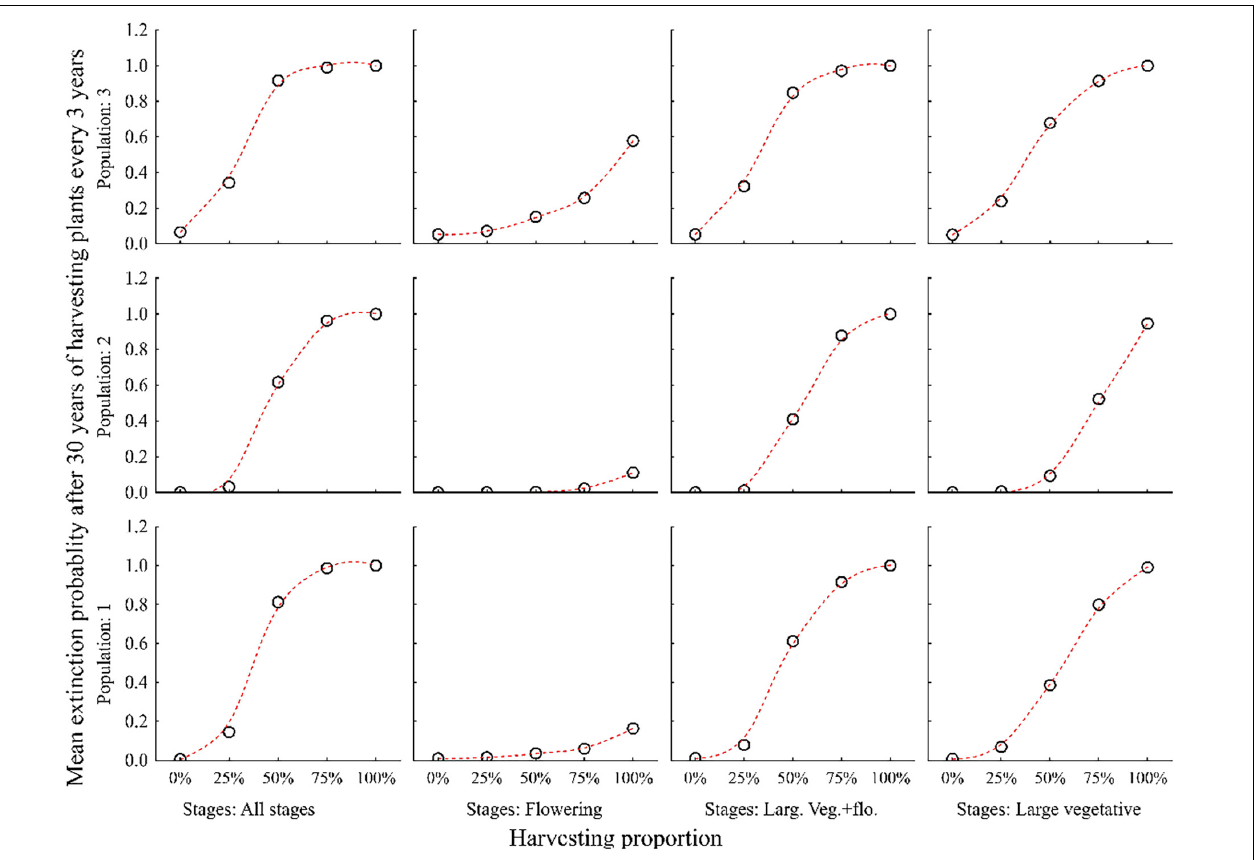
FIGURE 6 | Probabilities of three populations of C. acuminatum becoming extinct in 30 years when different percentages (0, 25, 50, 75, and 100%) of all individuals, only large vegetative and flowering, only large vegetative or only flowering stages are harvested every 3